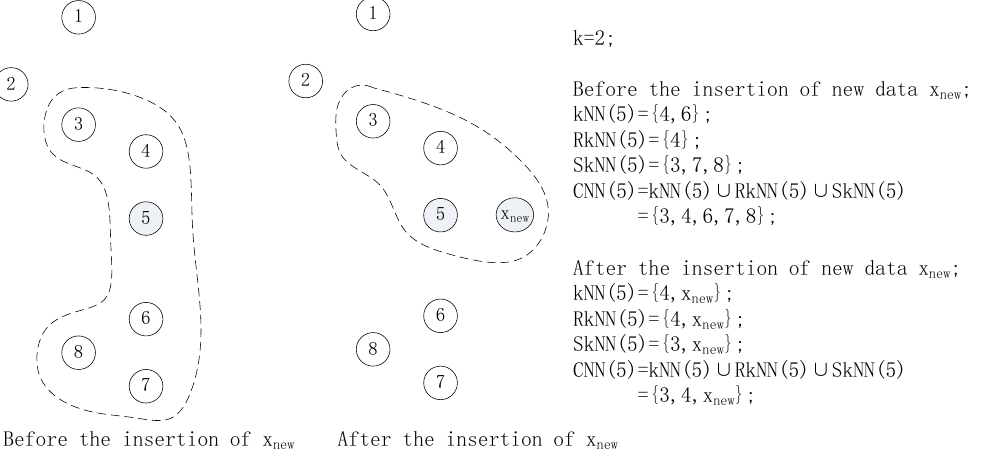
Figure 2. The influence of inserting new data to the local neighborhood.